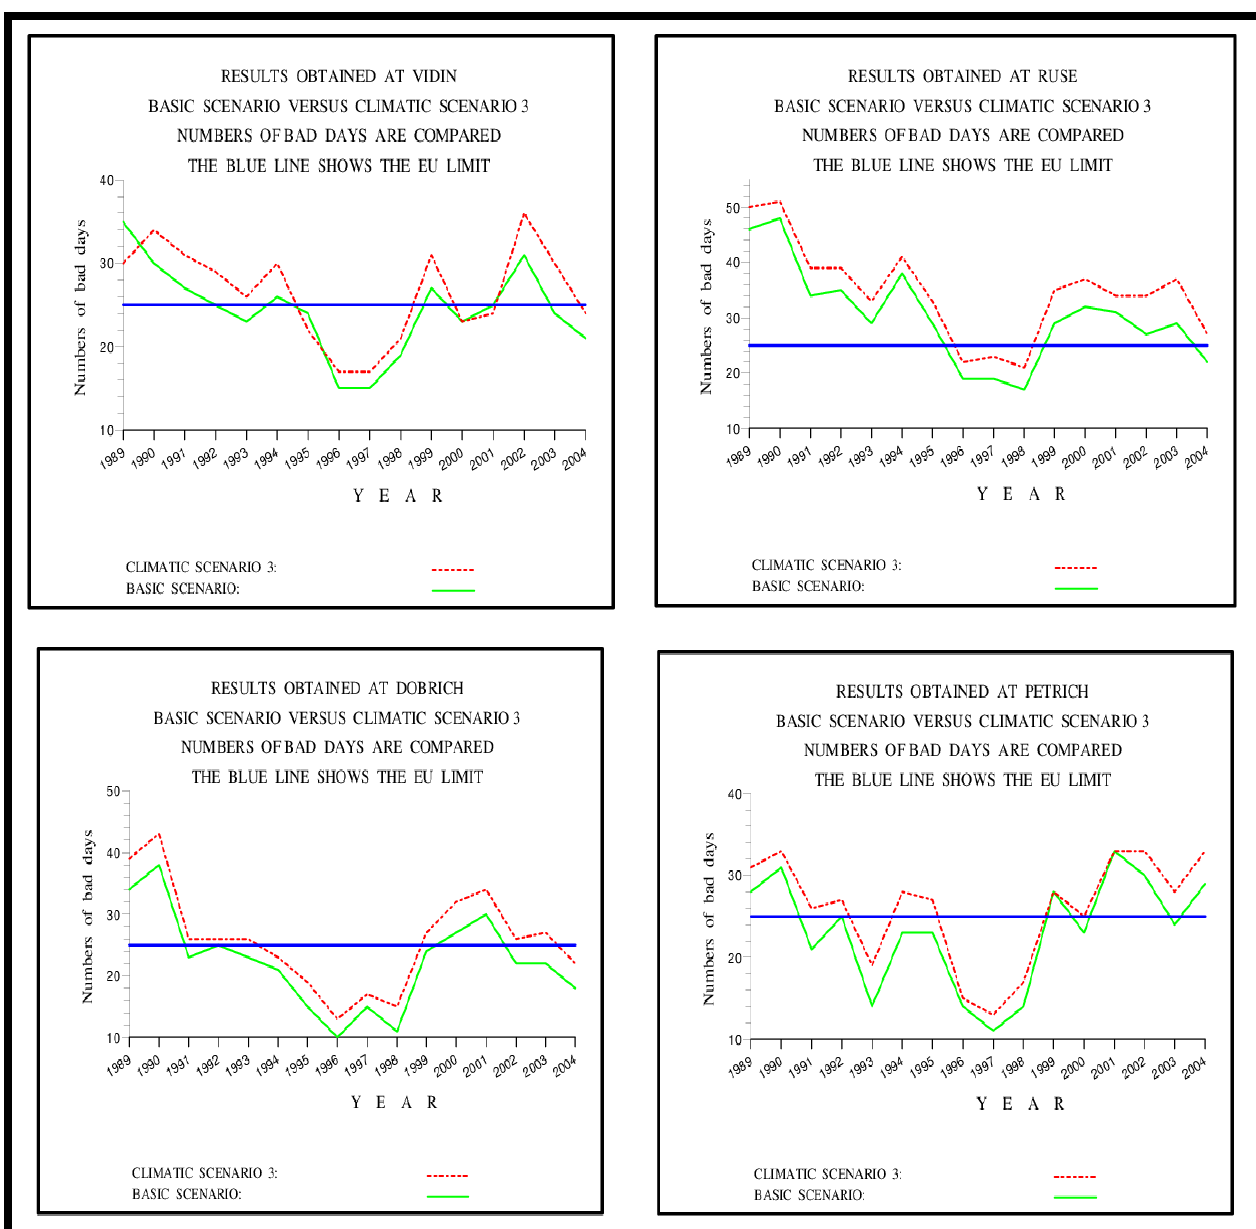
Figure 10. Results obtained in four Bulgarian towns: Vidin, Ruse, Dobrich and Petrich. It is clearly seen that also in this case the Third Climatic Scenario is consistently resulting in an increase of the numbers of “bad-days” when it is compared with the Basic